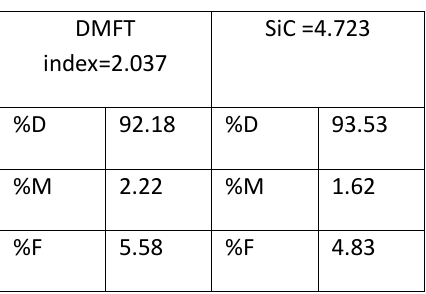
Table 1: DMFT index, Significant caries index and percentile of D, M, F. DMFT